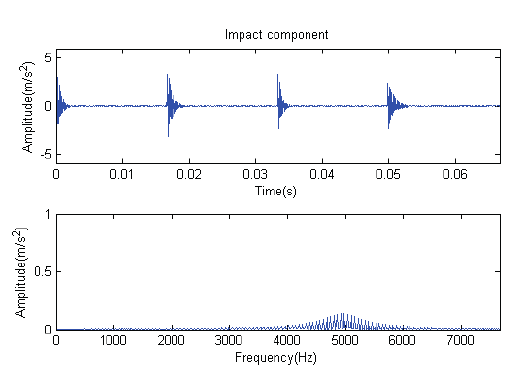
Figure 33. Impact component.